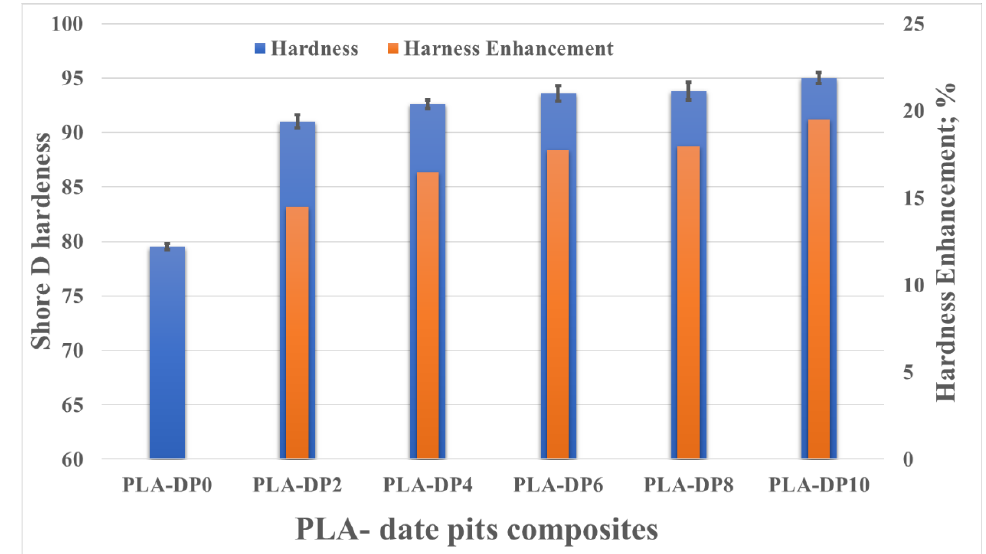
Figure 10. PLA composite harness for different date pit contents.